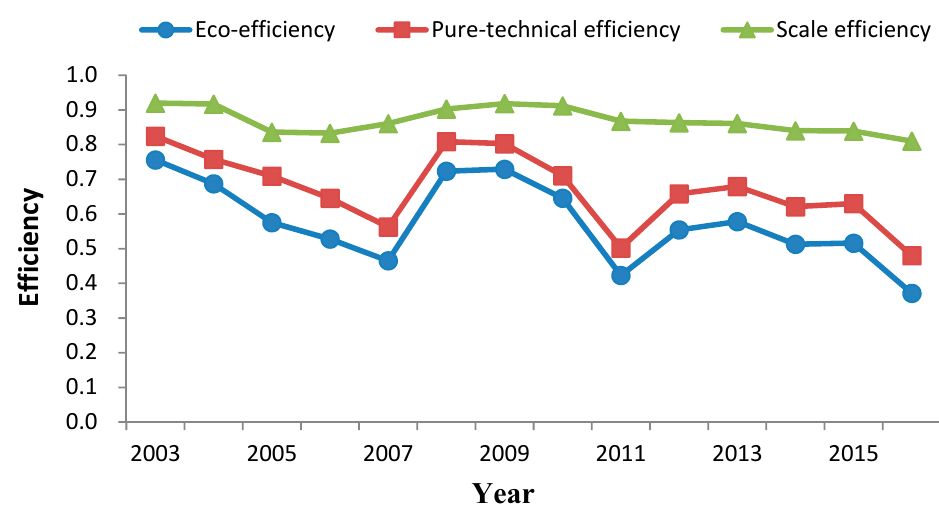
Figure 3. Eco-efficiency of SOFEs from 2003 to 2016. Note: calculated based on data from the Chinese Forestry Statistical Yearbook and China Statistical Yearbook.